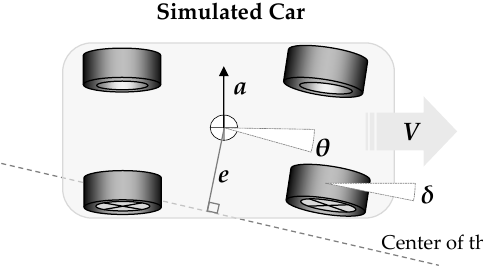
Figure 3. Most relevant variables pertinent to the state of the car.